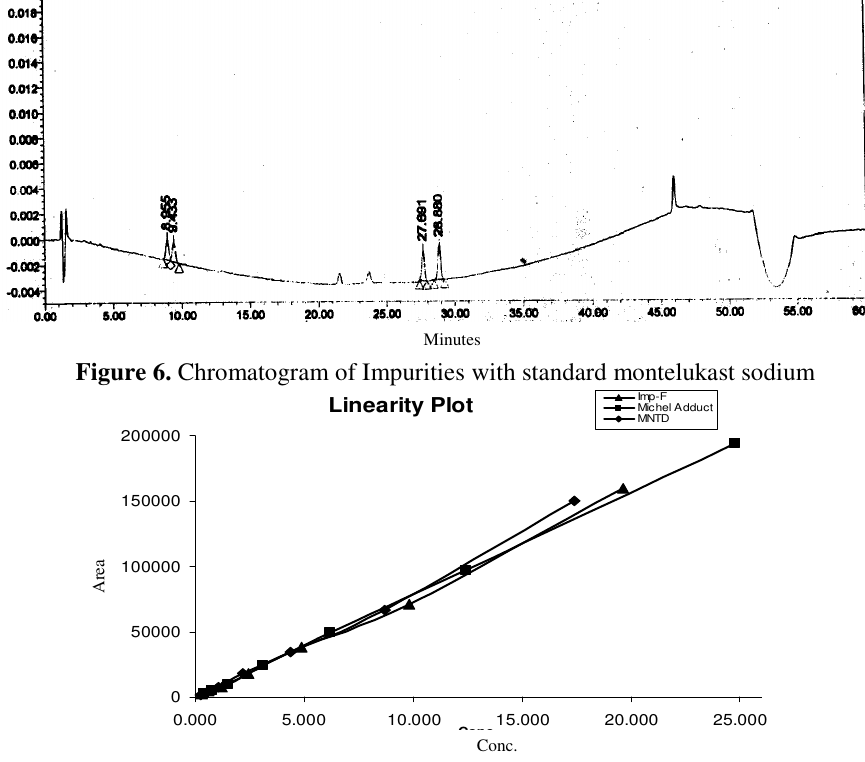
Figure 7. Linearity plot of impurities and